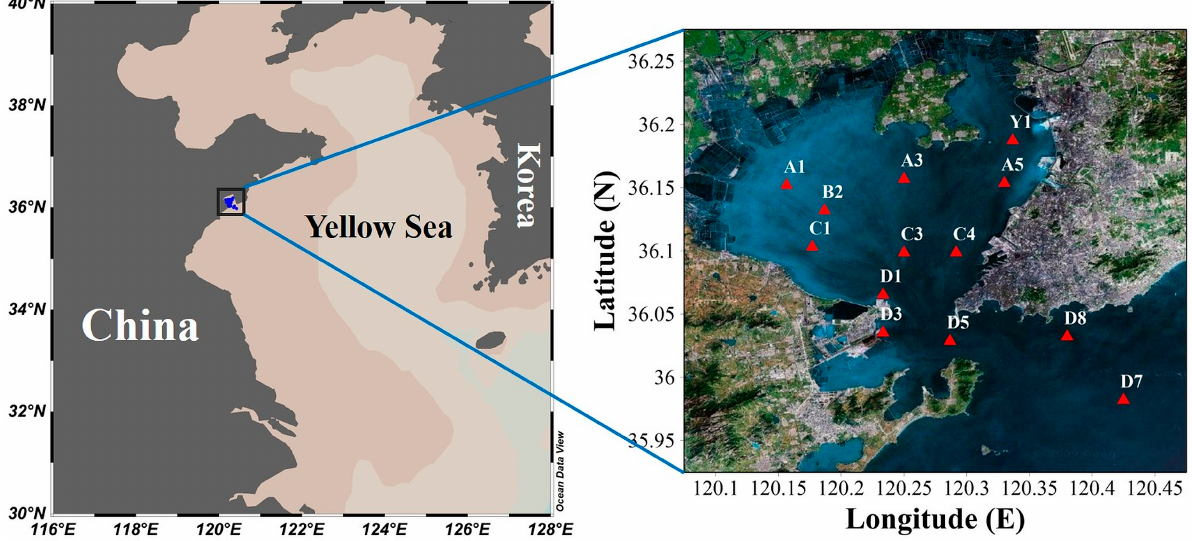
Figure 1. The location of the Jiaozhou Bay and sampling stations in the Jiaozhou Bay.